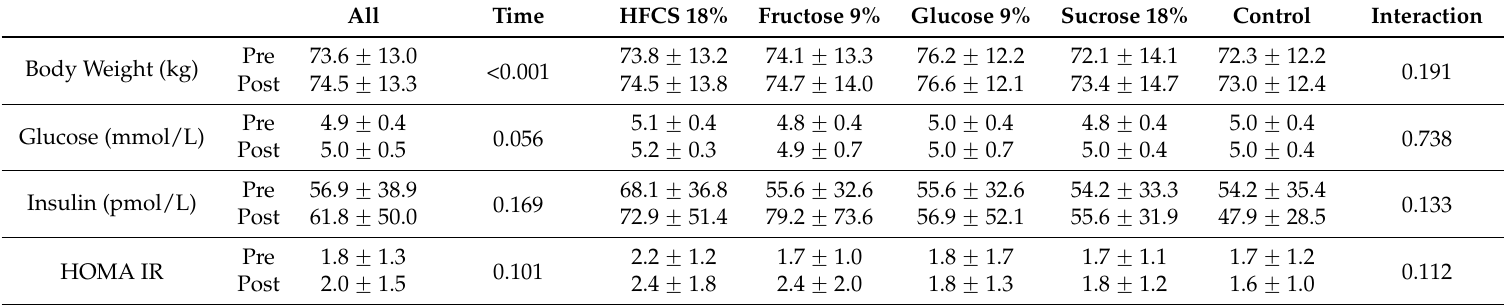
Table 4. Fasting Measures obtained before and after ten weeks of daily consumption of sugar sweetened milk or unsweetened control milk. All Time